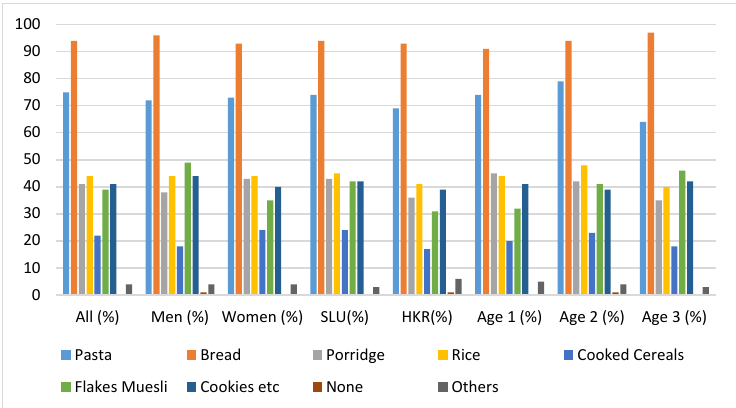
Figure 2. The frequency of consumption given in percentages for each group of cereal based products per week. The category “others” included couscous, rice cookies, crispbread, beer, pancakes, quinoa, millet, seeds, gluten free, buck wheat, and bulgur.